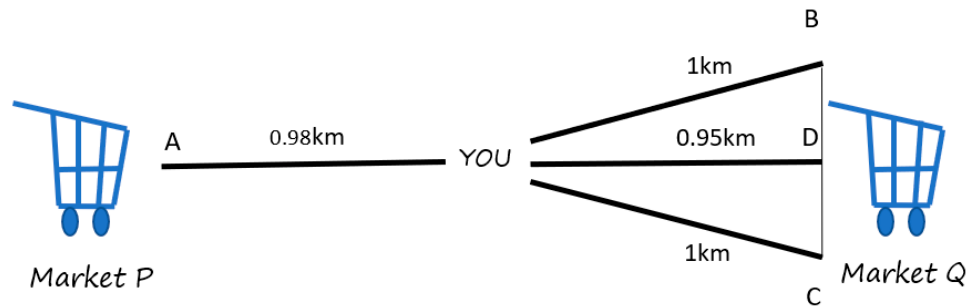
Figure 1. Distances and directions of two markets.